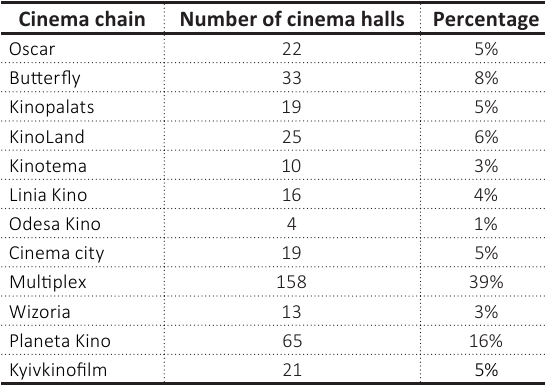
Table 1. Number of halls in a cinema chain in